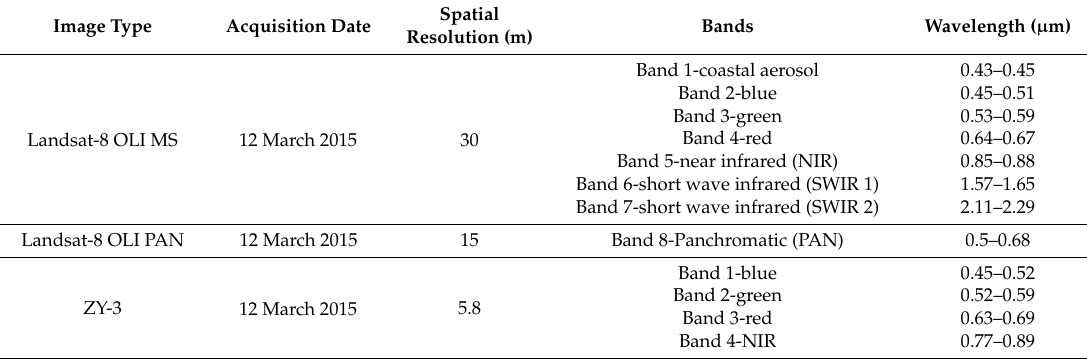
Table 1. Specifications of Landsat-8 OLI MS, PAN images and ZiYuan-3 surveying satellite (ZY-3) image. Image